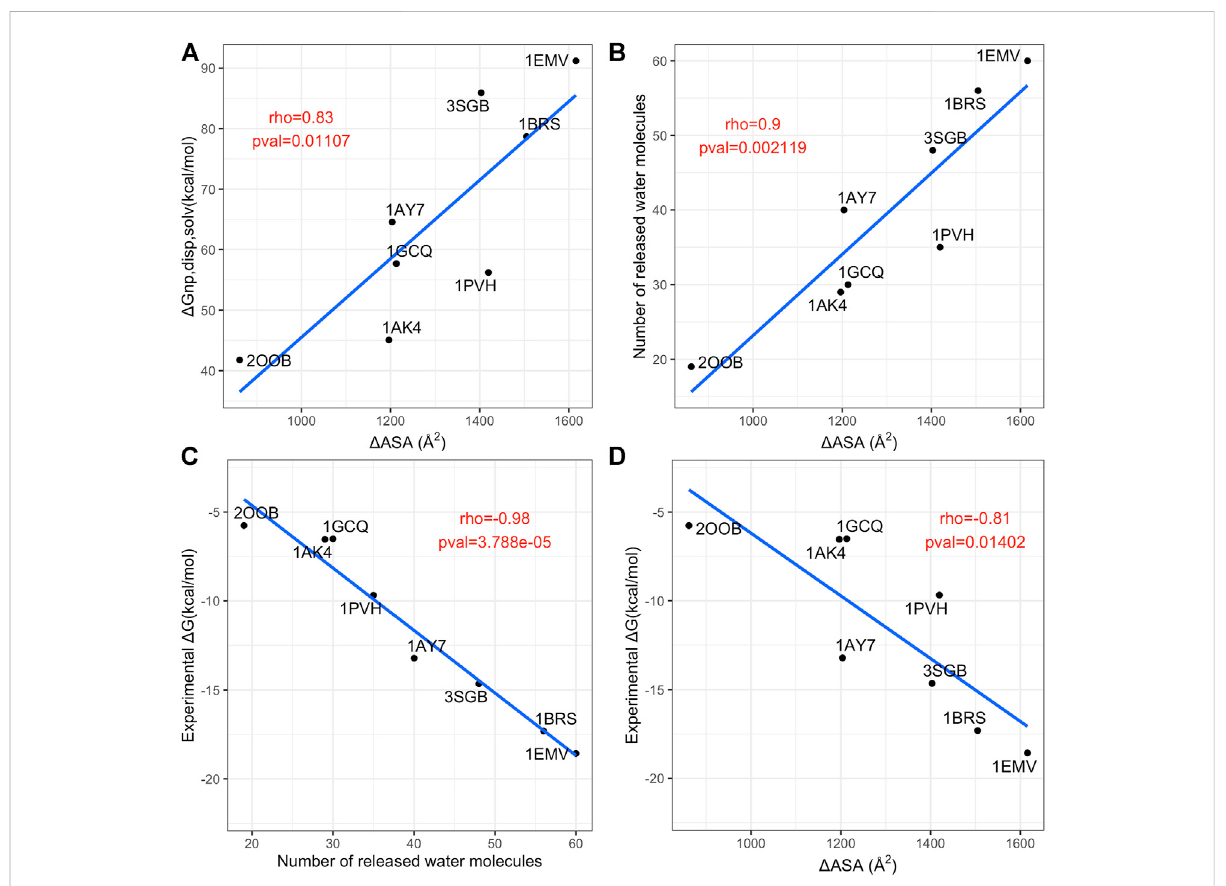
FIGURE 8 Analysis of contributions to the non-polar solvation energy. (A) Scatterplot of the interface size ( x axis) versus dispersive solvatation energy, Δ G y axis). (B) Scatterplot oftheinterface size( x axis)versusnumberofreleasedwater molecules. (C) scatterplotofthenumber ofreleased np,disp,solv ( watermolecules( x axis)versustheexperimentalbindingaf fi nity( y axis). (D) scatterplotofinterfacesize( x axis)versustheexperimentalbindingaf fi nity ( y axis). In each panel, the blue line is the linear regression fi t and the Pearson rho coef fi cient and associated p -values are annotated in